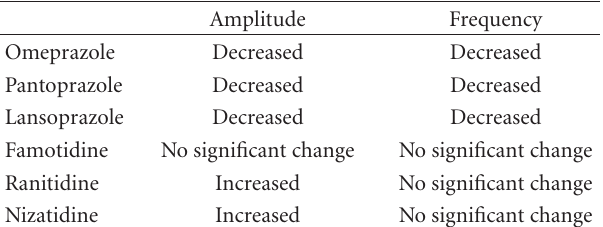
Table 1: E ff ects of proton pump inhibitors and H 2 receptor antag- onist agents on amplitude and frequency of the spontaneous con-